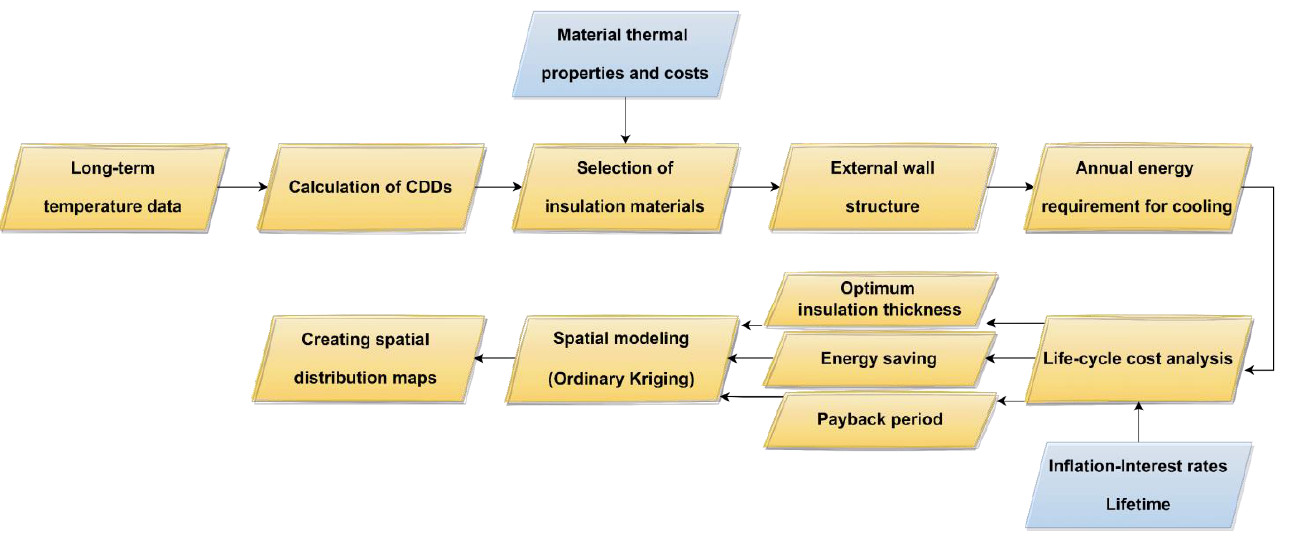
Figure 1. Flowchart of the simulation model.